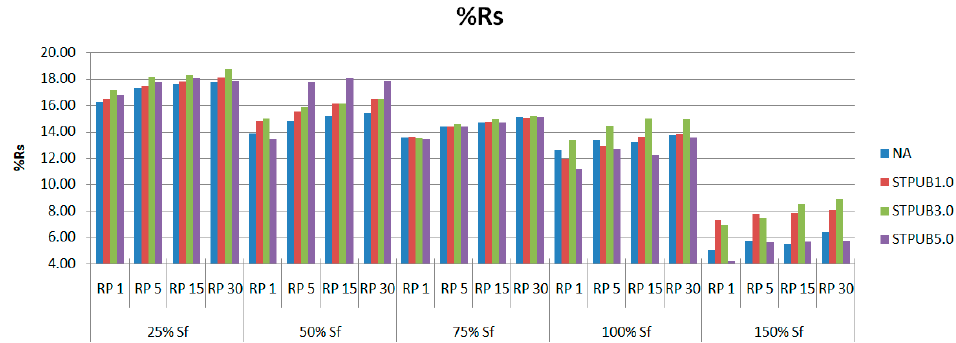
Figure 14. Percent restoration (%Rs) related to each bitumen at di ff erent damage levels and